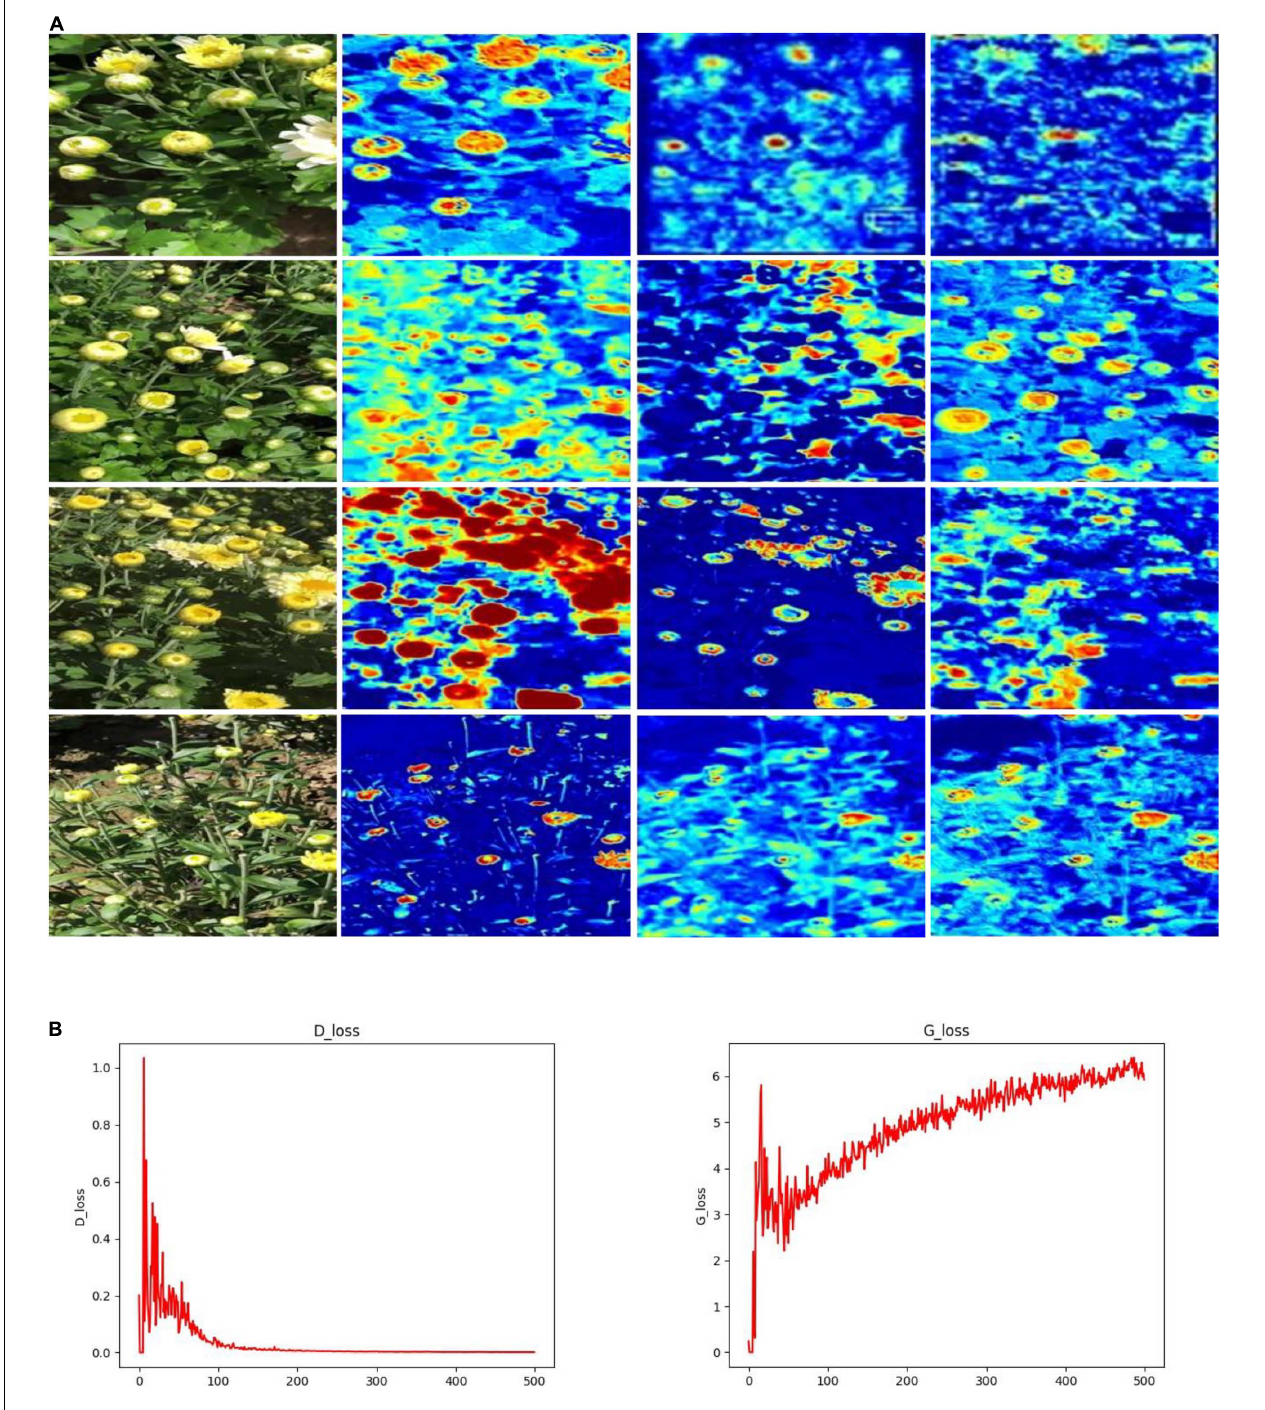
FIGURE 8 | (A) Visualization results and (B,C) training